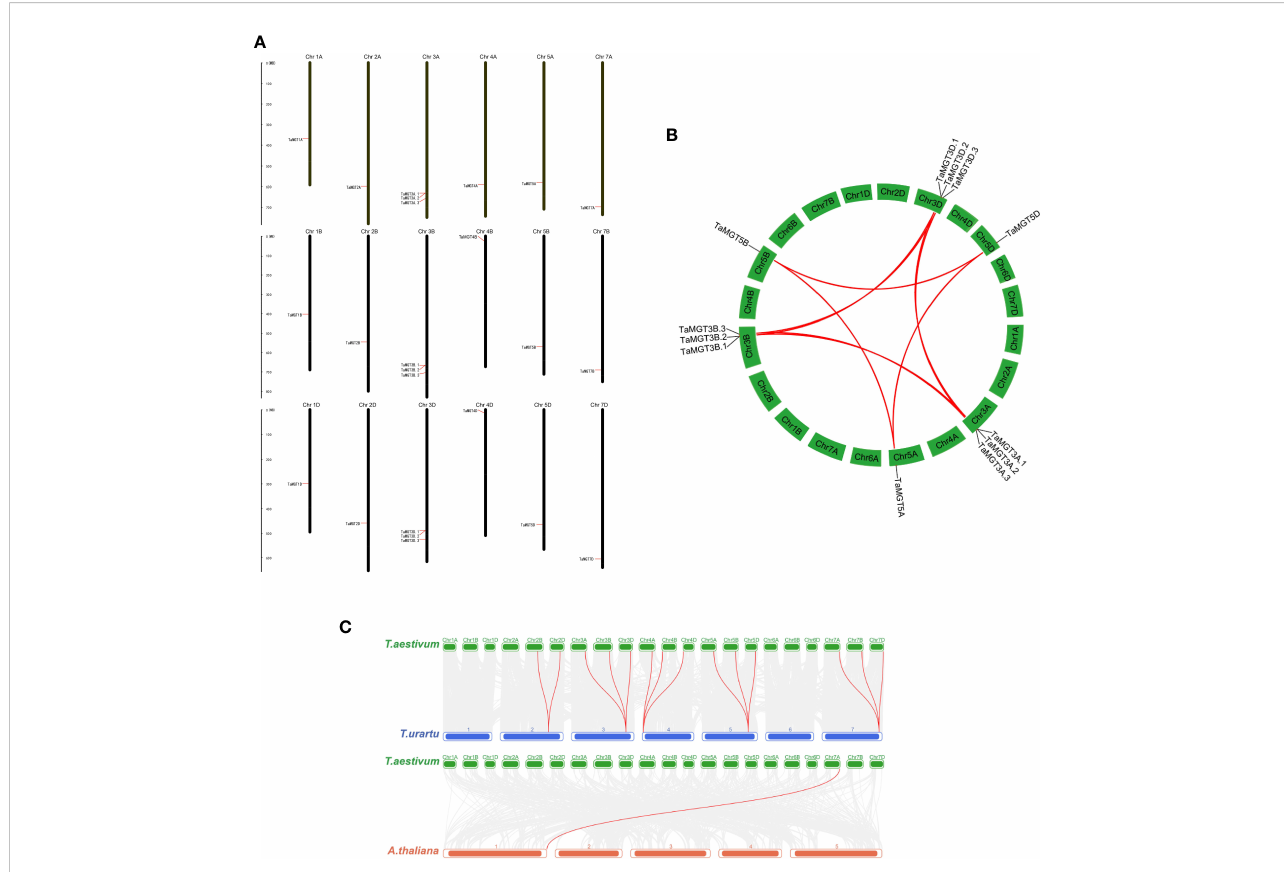
FIGURE 4 Chromosomal localization and gene duplication of TaMGTs genes. (A) Location of TaMGTs genes on chromosomes, with black representing chromosomes. (B) Gene duplication events in the wheat MGT gene family, where the curves represent gene duplication between chromosomes; the collinearity genes on chromosome 3A, 3B, 3C are highlighted with red lines. (C) Collinearity analysis of wheat with Arabidopsis thaliana and Triticum urartu. The gray line in the background indicates a collinear block in the genome of wheat and Arabidopsis thaliana and Triticum urartu, while the red line highlights the homologous MGT gene